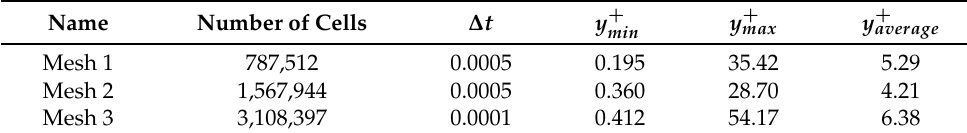
Figure 13: Mean axial velocity at several cross sections for different mesh resolutions (red: Mesh 1, green: Mesh 2, blue: Mesh 3, dots: experiments)